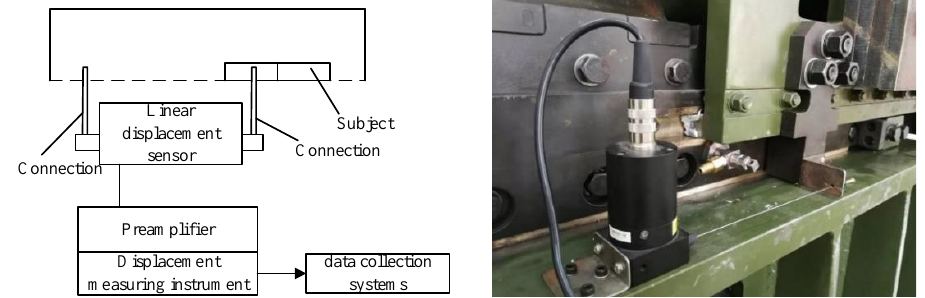
Fig. 4 . Schematic of displacement test. Fig. 5 . Displacement sensor